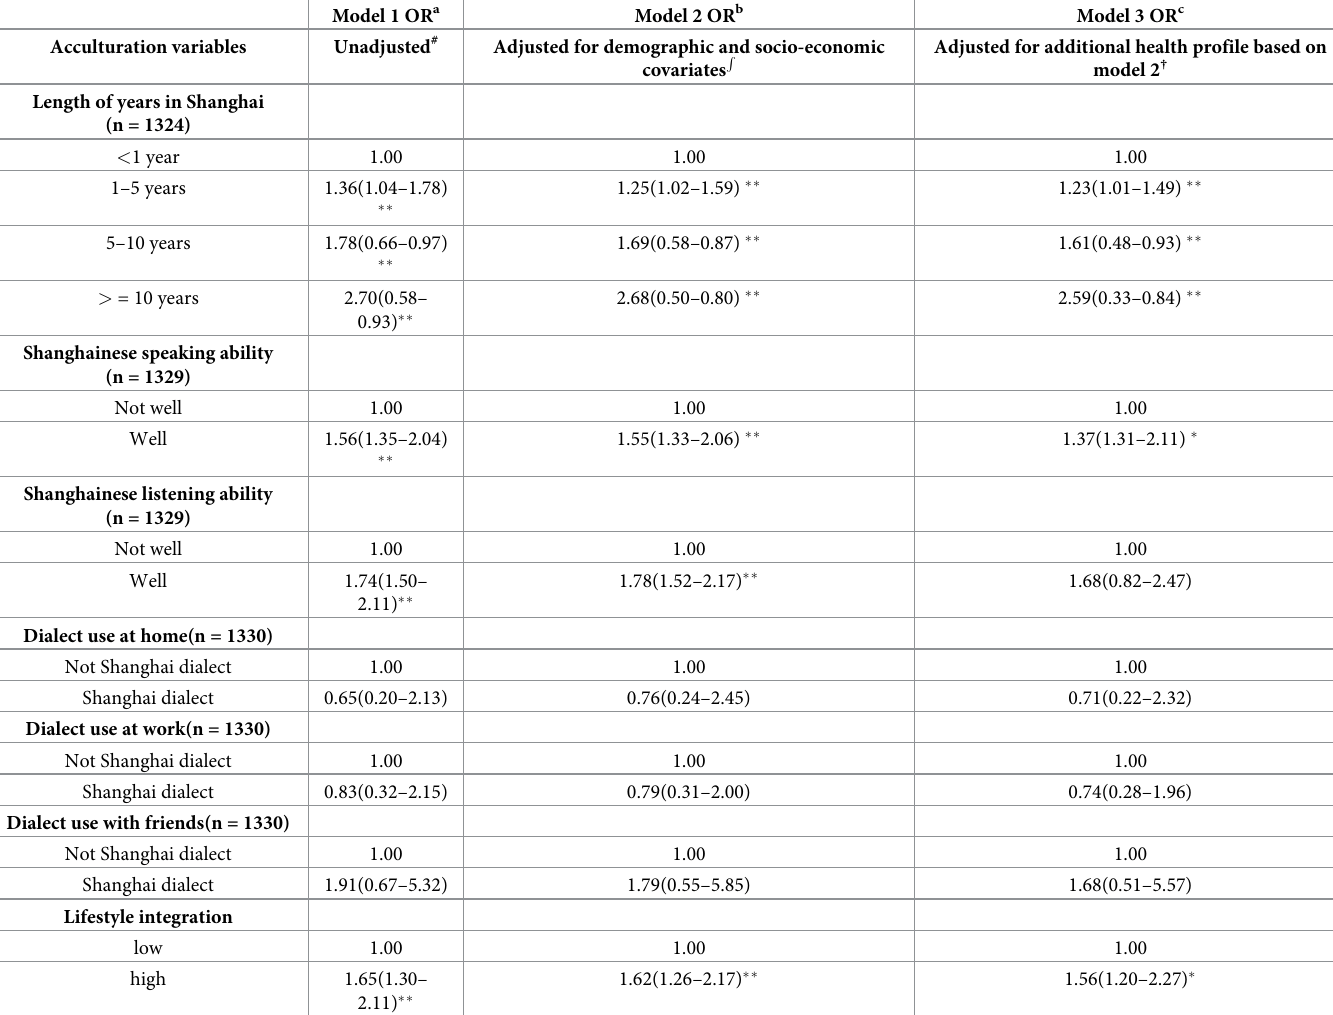
Table 2. Multivariable logistic regression models to assess the association between immigrant’s acculturation and physician trust in internal migrants in Shanghai (n = 1330). Model 1 OR a Model 2 OR